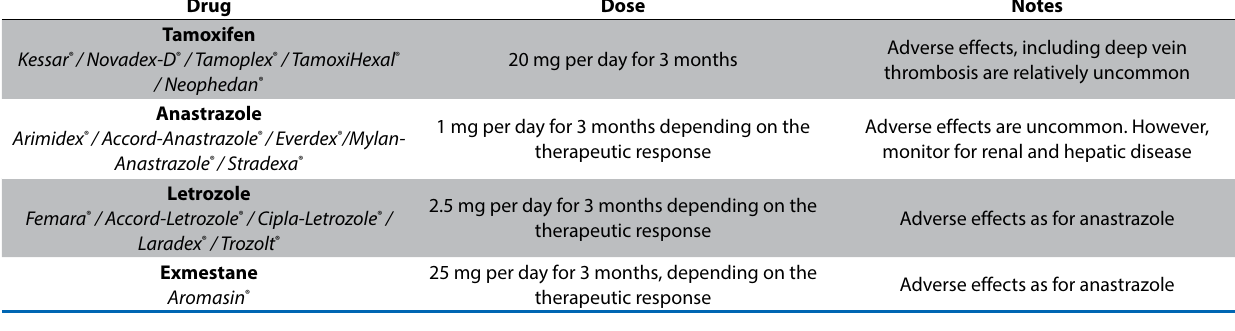
Table 5 - Drugs recommended for the treatment of hirsutism Drug / Formulation